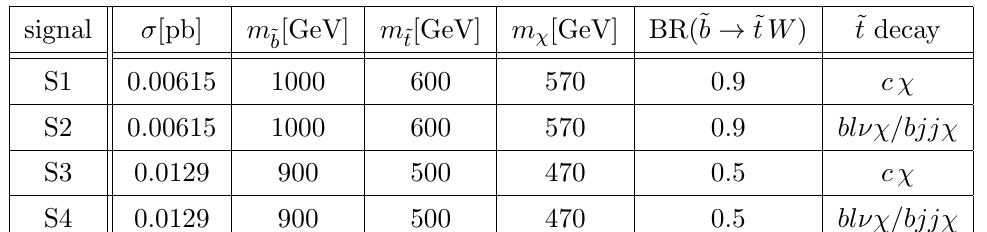
Table 1 . Signal samples used for the case studies in the 2 ‘ + E miss 1 b 1 ‘ + E miss channel (S3 & T